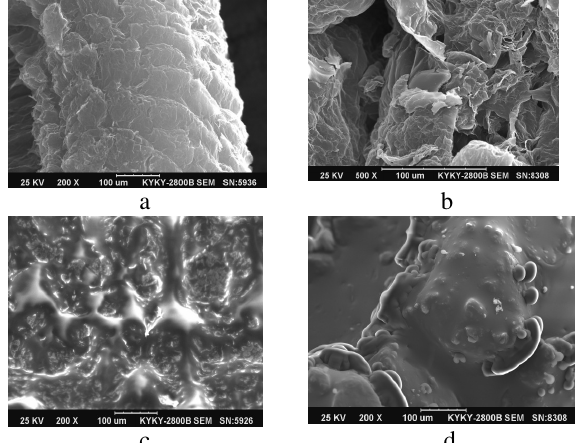
Figure 3. SEM micrograph of EG, (a) EG, (b) EG saturated by PEG (10000), (c) EG saturated by SD 300 oil, (d) EG saturated by salad